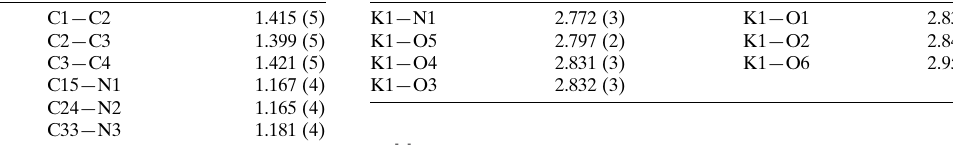
Table 4 Hydrogen-bond geometry (A˚ , (cid:5) ) for 2 .